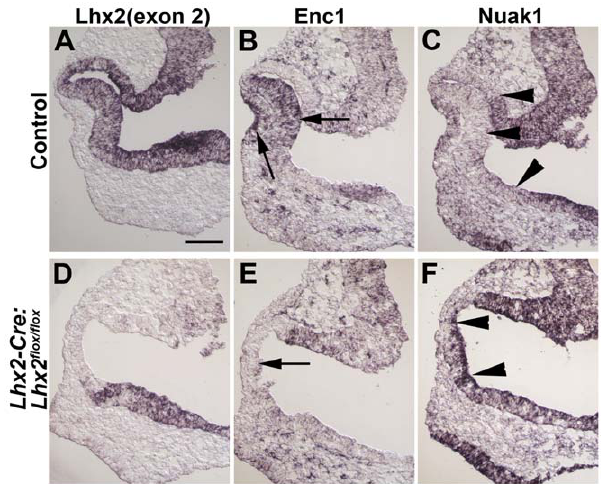
Figure 6. Identification of novel genes putatively linked to Lhx2 function in eye development. Gene expression analyses are performed at E10 in control animals (A–C) and in conditional mutants (D–F) on coronal sections. In situ hybridisation analyses to detect exon 2 (exon2) of the Lhx2 gene in the control embryo (A) and in embryos where Lhx2 has been conditionally inactivated (D) to reveal the domain where the Lhx2 gene has been inactivated. In situ hybridisation analyses to detect expression of Enc1 in the control embryo (B) and in the conditional mutant embryo (E). Enc1 is expressed in the prospective neural retina and lens placode and this expression is not detected in the mutant optic vesicle (arrows). In situ hybridisation analyses to detect Nuak1 expression in the control embryo (C) and in the conditional mutant embryo (F). Nuak1 expression is excluded from the optic vesicle in the control embryos whereas its expression extends into this domain in the mutant optic vesicle (arrow heads). Scale bar: 100 m m.